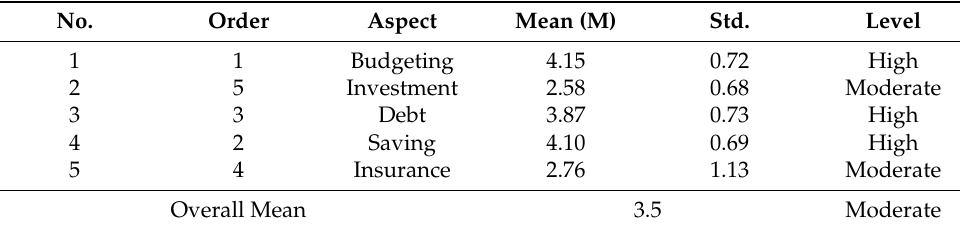
Table 3. Mean and std. values for financial literacy dimensions for the Saudi sample ( n = 887).